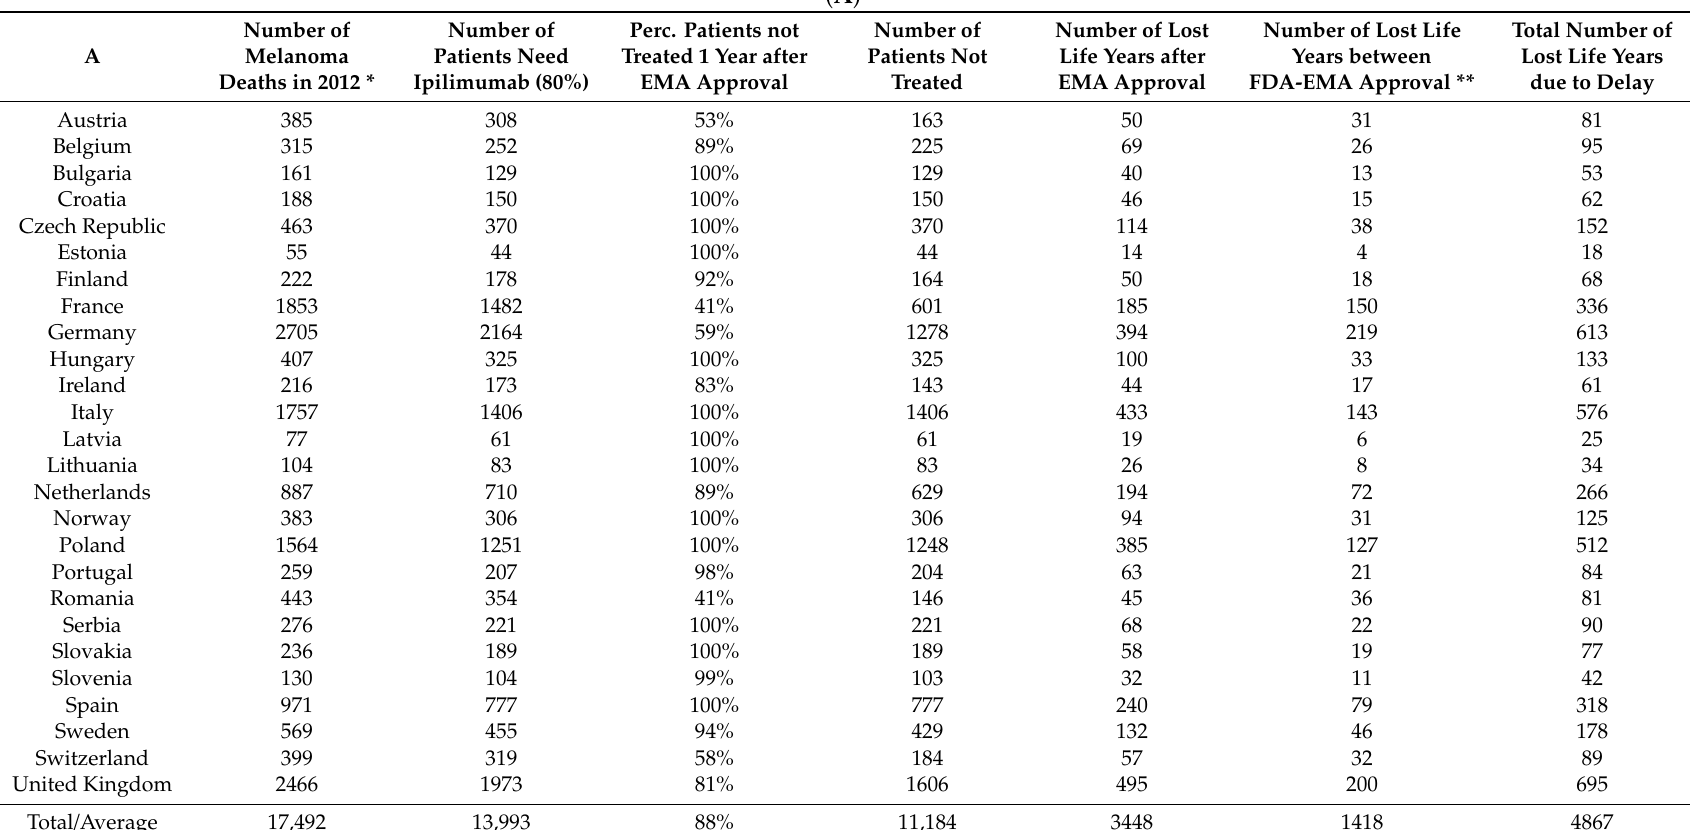
Table A3. Calculation of number of lost life years ipilimumab (A) and abiraterone